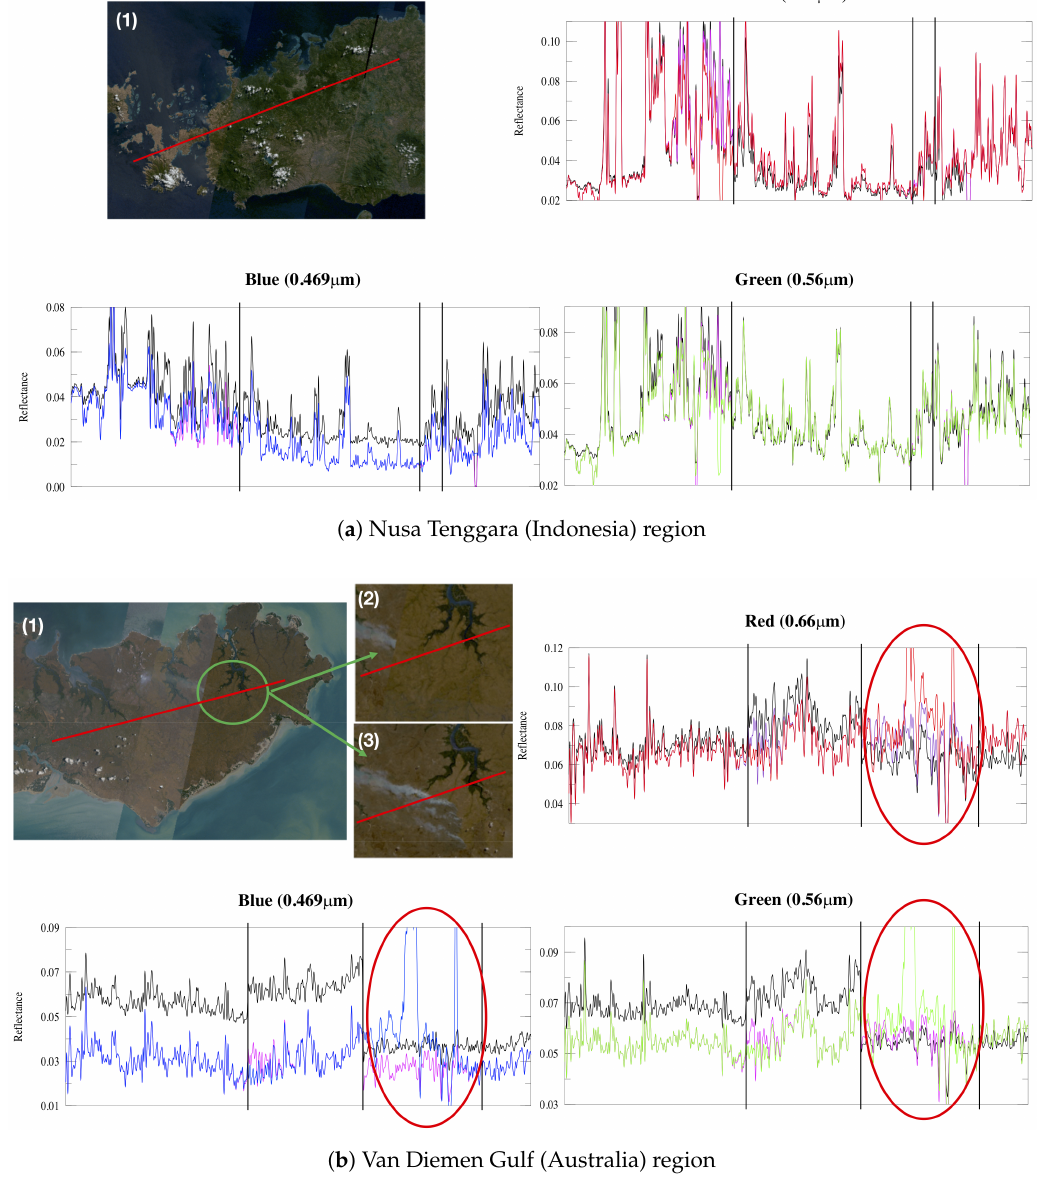
Figure 15. RGB reflectance values across the red marked transects; black lines refer to the patch of the natural color ASTER granules (1); magenta lines to the patch of IDT colorized granules (2); red, green, and blue lines correspond to the final reflectance values in the seamless CLAMS mosaic (3). Black vertical lines mark the granules